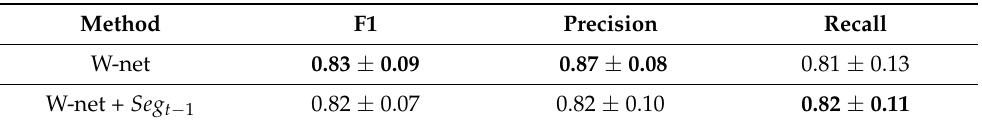
Figure 3. Example of three classes W-net output. From left to right: original image, ground truth, 3-class W-net output. Table 2. Average W-net dice scores on the training